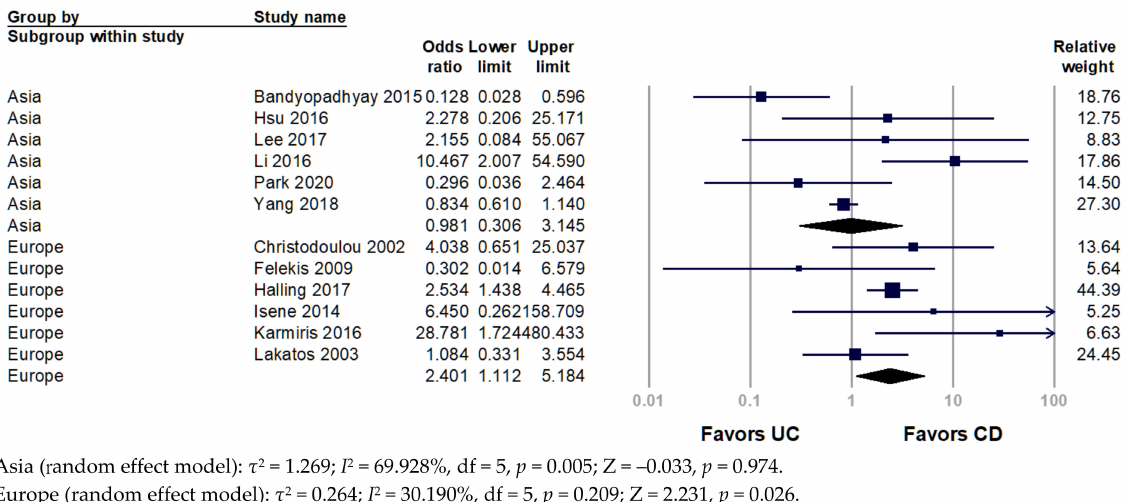
Figure 3. Forest plot for the prevalence of ocular extra-intestinal manifestation among adult patients with inflammatory bowel disease stratified by world region: ( A ) uveitis; ( B ) episcleritis. CD, Crohn’s disease; UC, ulcerative colitis.